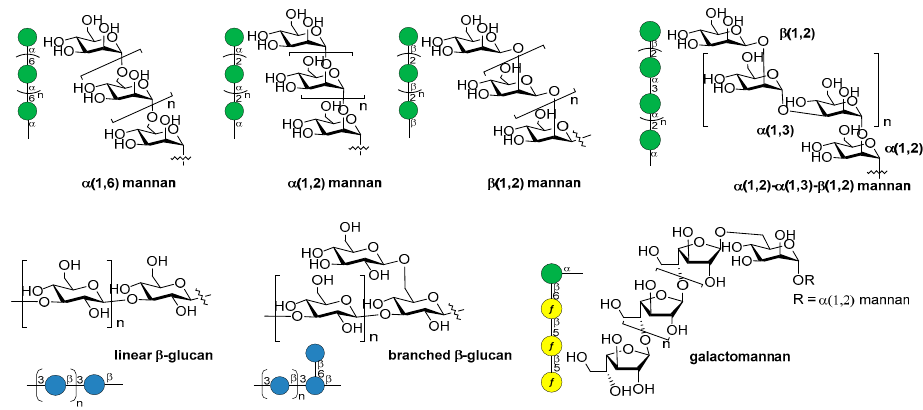
Figure 30. Examples of mannan, β -glucan and galactomannan components of fungal cell walls.